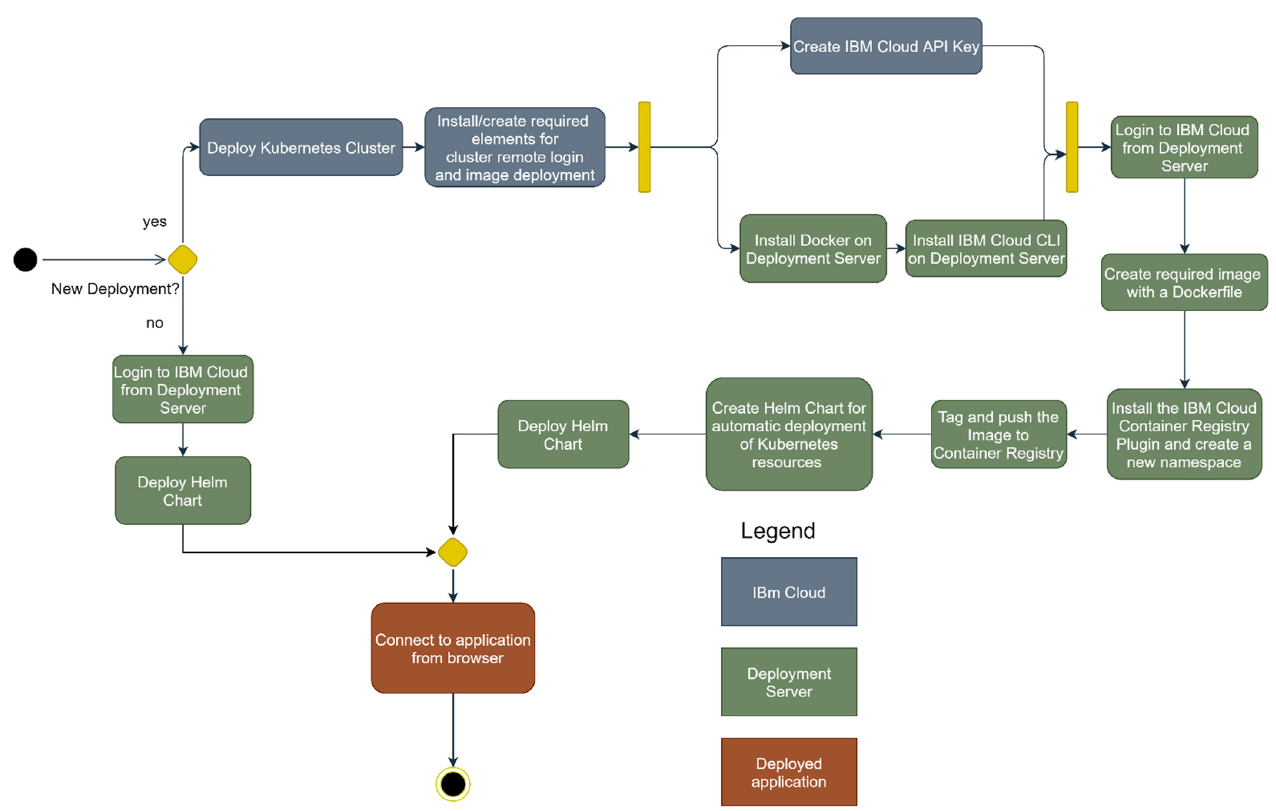
Figure 1. The manual deployment process for the IBM Cloud.